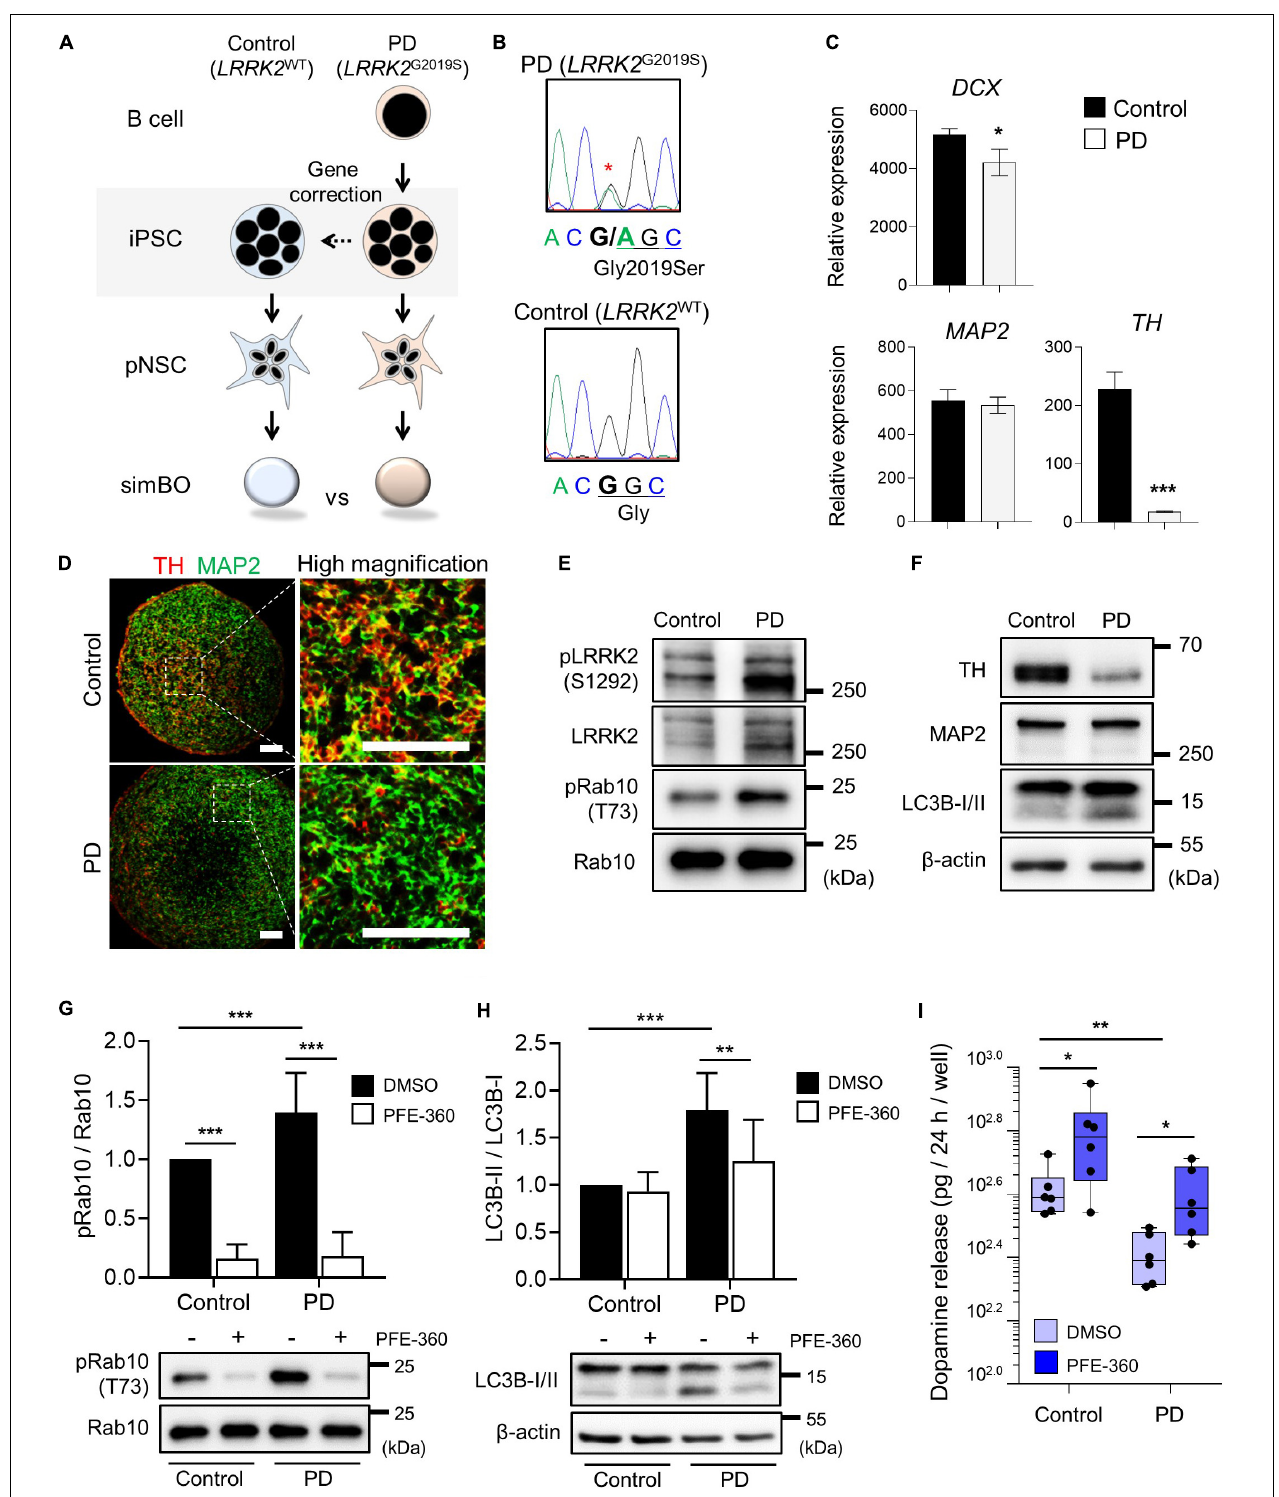
FIGURE 7 | Parkinson’s modeling with midbrain-like simplified brain organoids (simBOs). (A) Schematic flow diagram to depict the establishment of PD patient-derived simBOs from harboring LRRK2 G2019S mutation (PD) and gene-corrected control iPSCs (Control). (B) DNA sequencing data for the LRRK2 G2019S (Gly to Ser) mutation and correction of this gene in the iPSCs. (C) Quantitative reverse transcription polymerase chain reaction (qRT-PCR) analysis for pan-neuronal